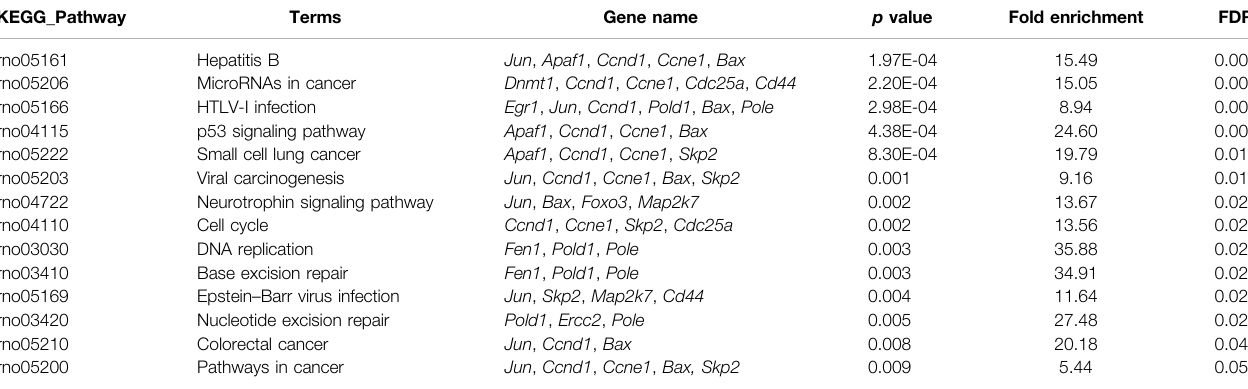
TABLE 6 | Enriched molecular pathways by differentially genes expressed in the female offspring mammary gland of LPD 35 group. KEGG_Pathway